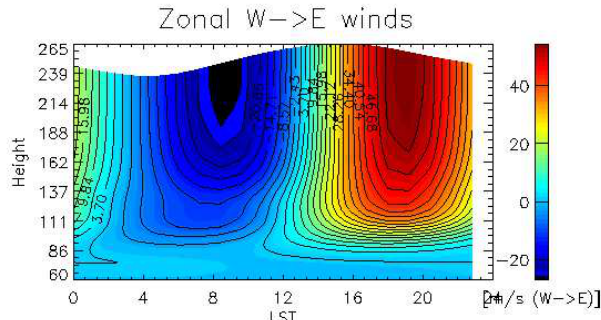
Fig. 5. The zonal wind velocity (positive eastward), local solar time (LST) vs height, from MarTIM, for solar minimum and L s =0 ◦ at +45 ◦ latitude.